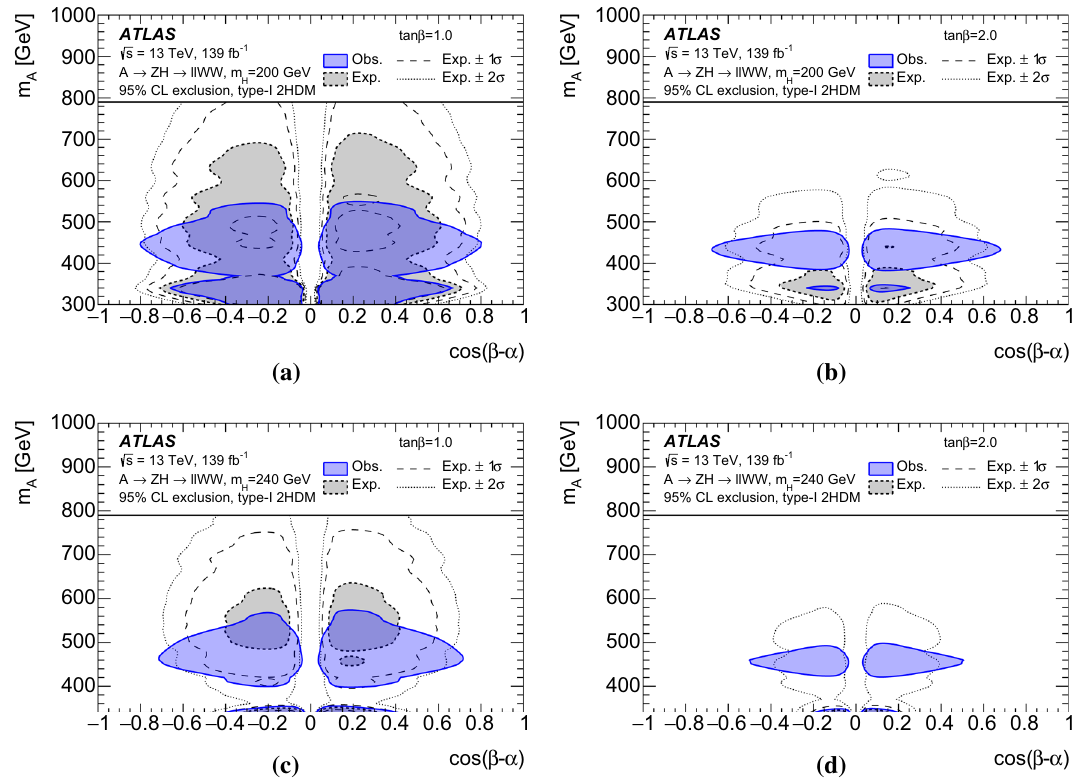
Fig. 14 Observed and expected 95% CL exclusion regions in the (cos (β − α) , m A ) plane for various tan β values for a , b m H = 200 GeV and c , d m H = 240 GeV in the context of type-I 2HDM for the (cid:6)(cid:6) WW